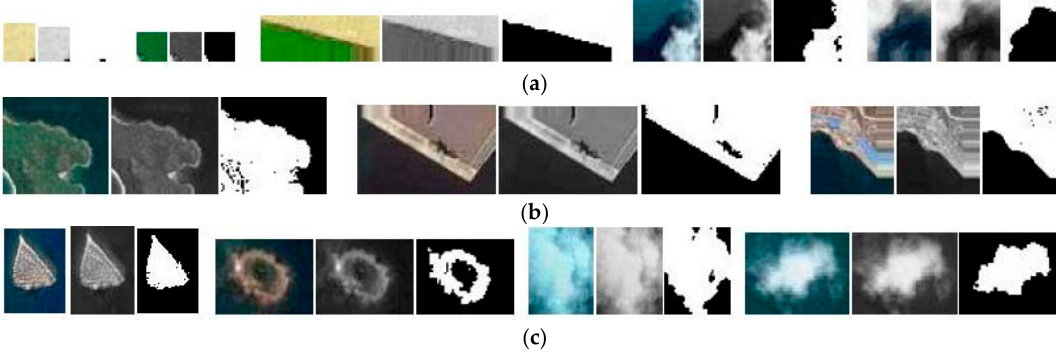
Figure 9. Some confusing chips. ( a ) very few target pixels in the chips, or the edges are covered with clouds; ( b ) the edges are covered with islands and coasts; and ( c ) the non-ship targets are inside the chips.